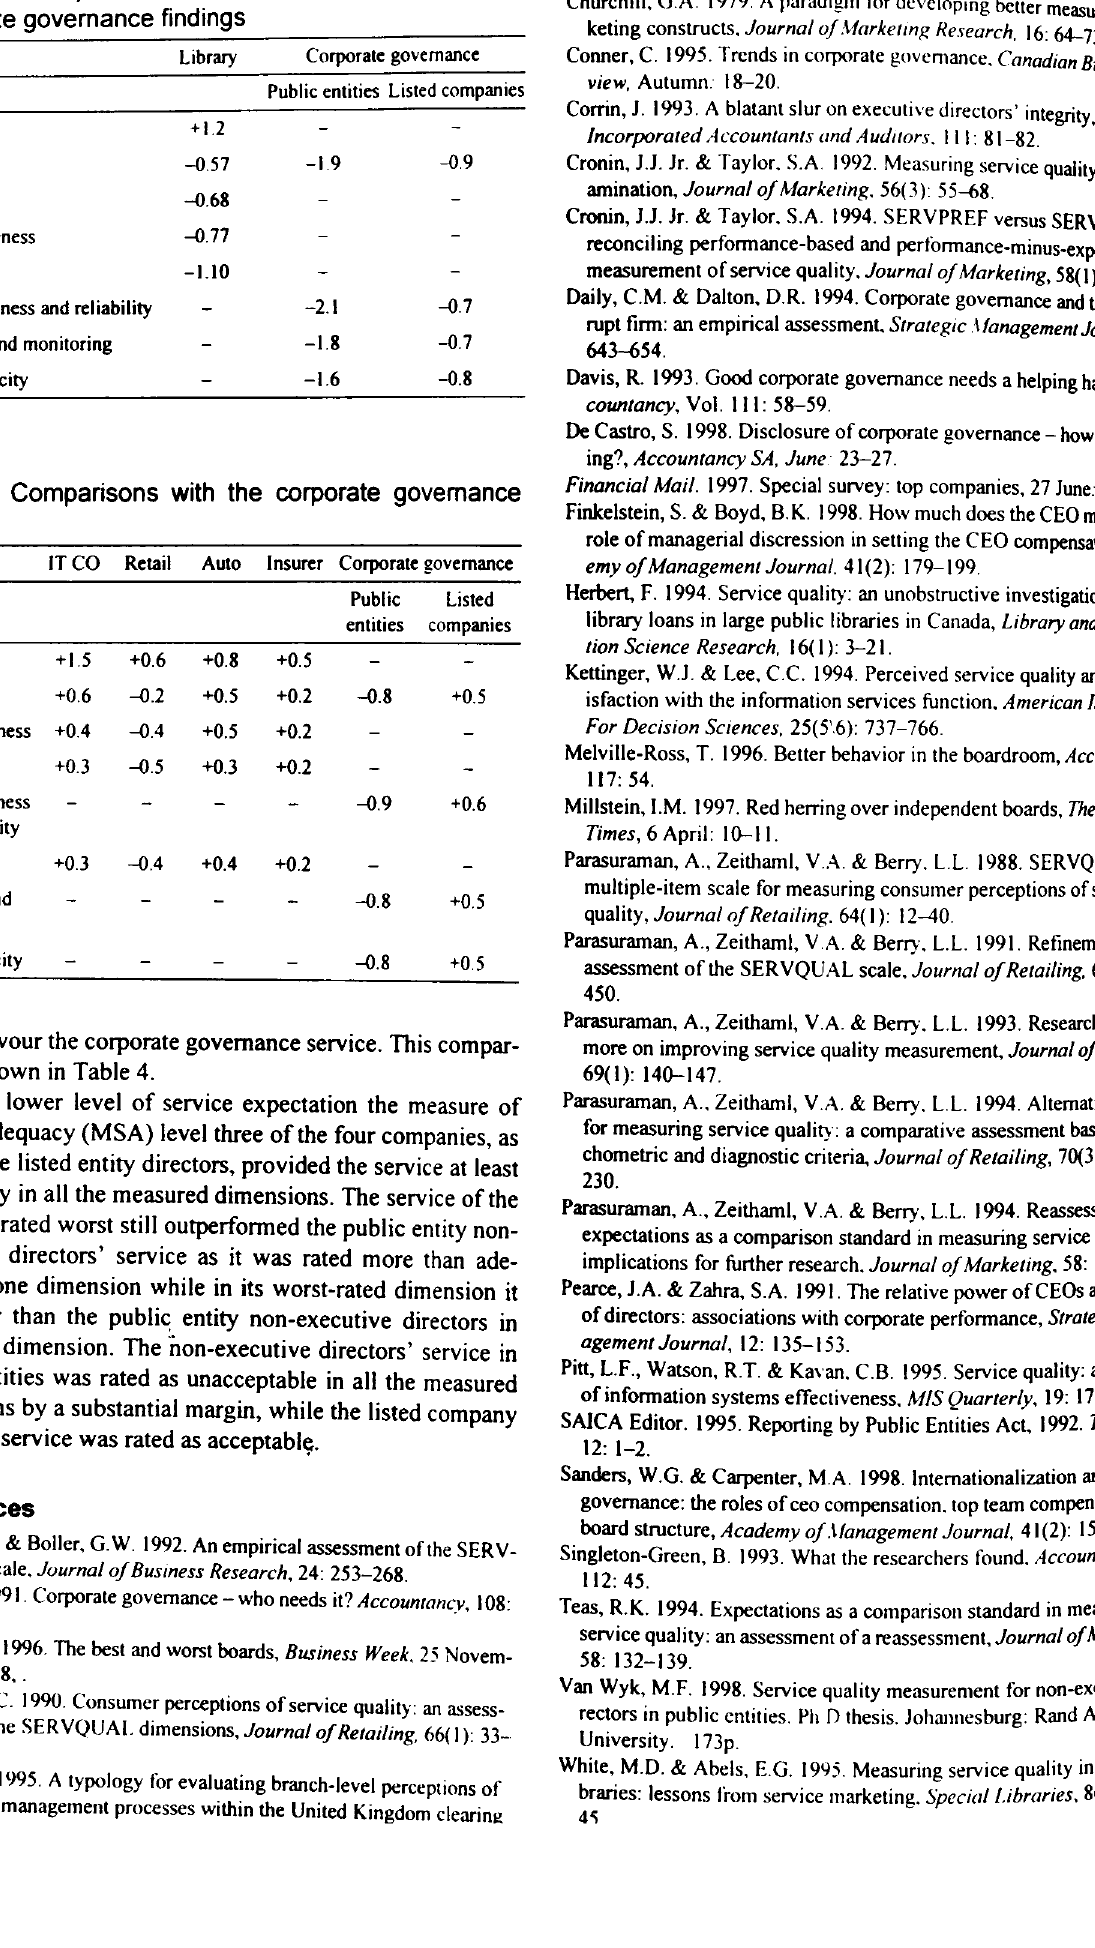
Table 3 Comparison of Herbert's results and the corP.orate governance findings